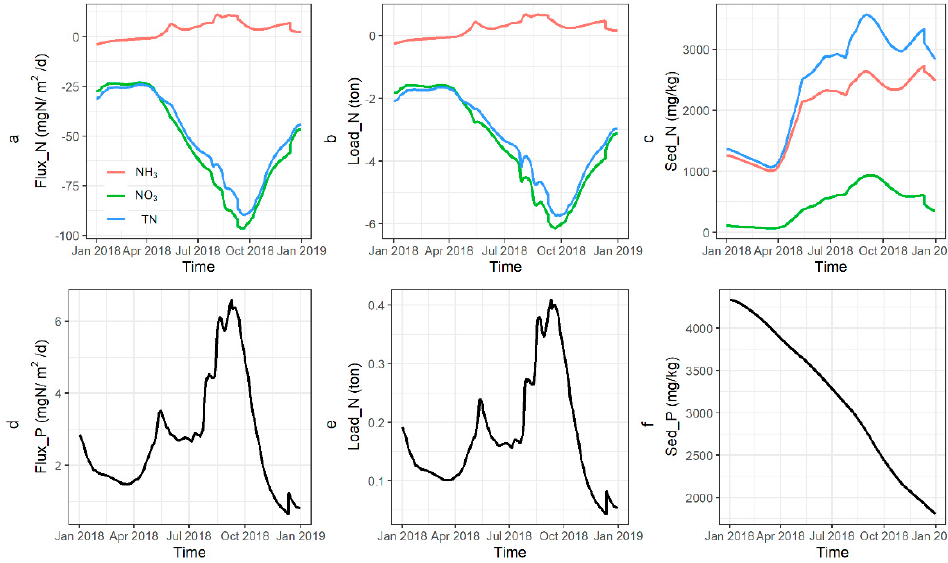
Figure 7. The LAKE2K model results of the sediment in 2018. Panels ( a , d ) show the sediment flux of nitrogen and phosphorus to the overlying water; panels ( b , e ) show the exchange load of nitrogen and phosphorus across the sediment–water interface; panels ( c , f ) show the contents of nitrogen and phosphorus in the sediments.